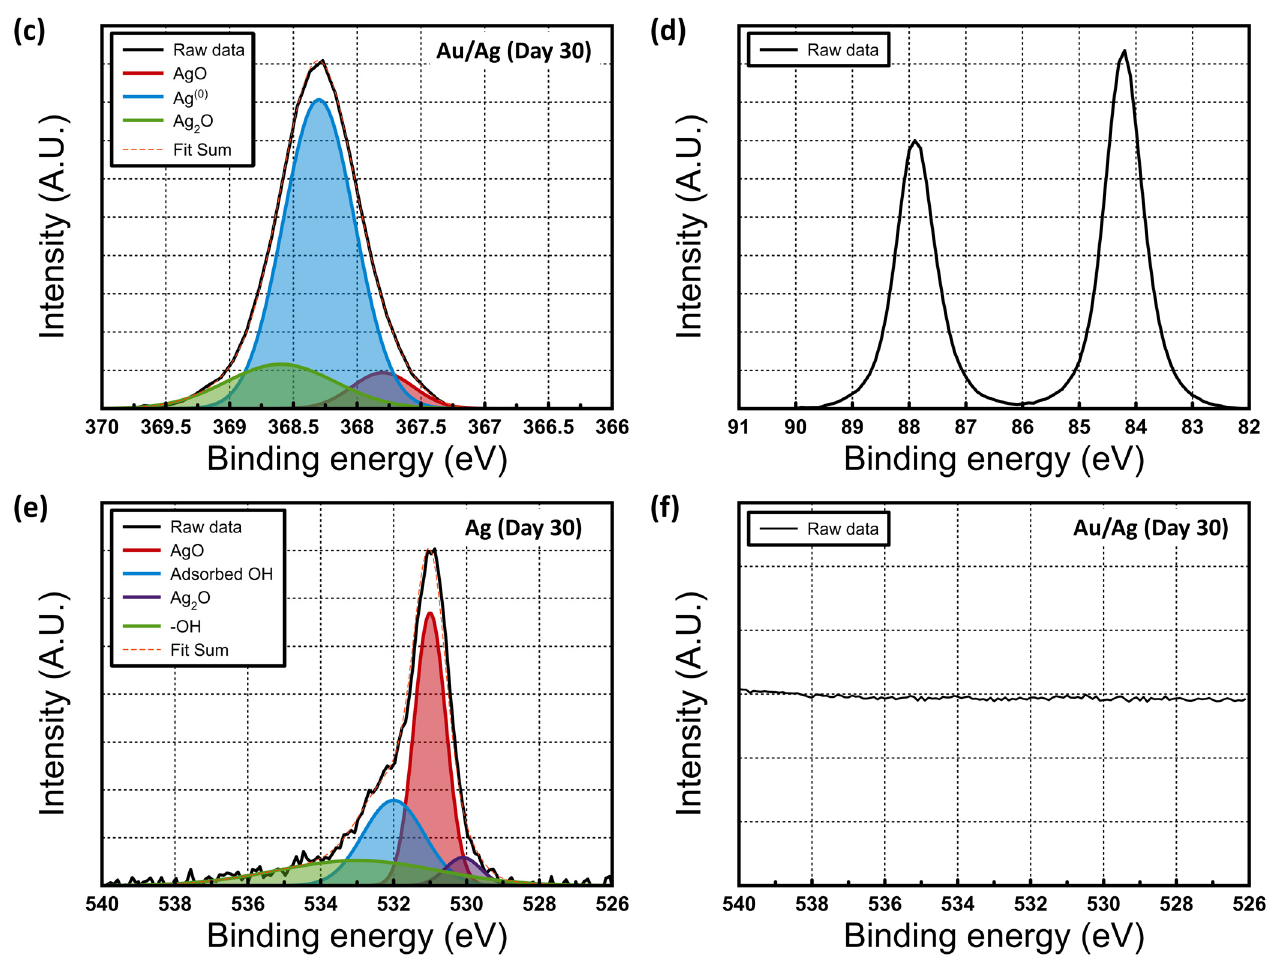
Figure 3. (a – c ) Ag 3d XPS data for Ag and Au-passivated Ag electrodes. ( d ) Au 4f doublet XPS spectral region of Au passivation layers. ( e , f ) O1s XPS data for Ag electrode and Au-passivated Ag electrodes, respectively, after being stored for one month in air.